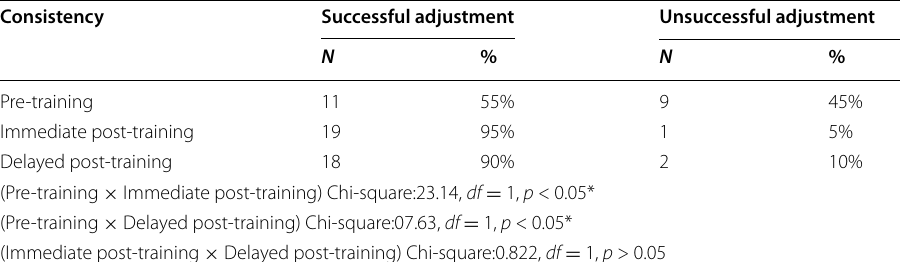
Table 11 Percentages of rater mean square fit statistics Fit range Pre-training Immediate post-training Delayed post- N % N % N % Fit < 0.06 4 20 0.6 fit 1.4 11 55 ≤ ≤ Fit >